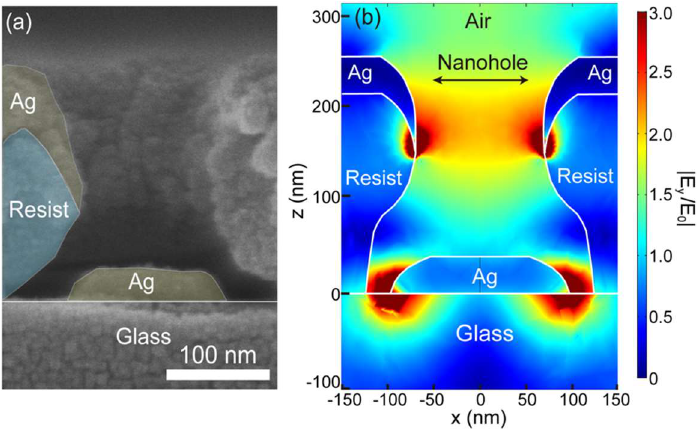
Figure 3. Electric field enhancement produced by plasmonic local heating. Cross-sectional view of nanohole: ( a ) scanning electron microscopy (SEM) image; and ( b ) electric field distribution.